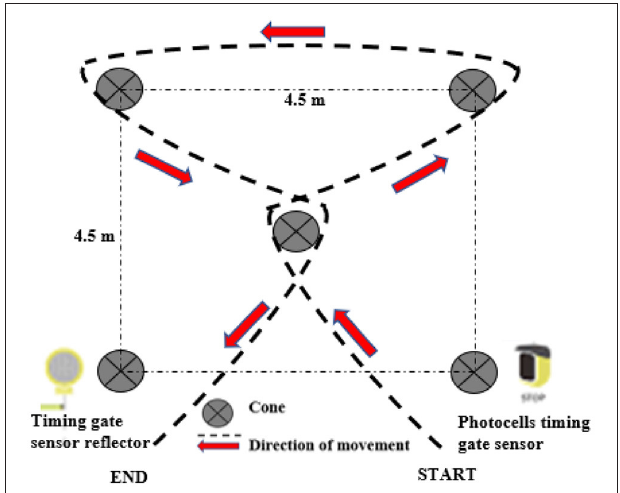
FIGURE 1 | Multiple V-cut pylon course functional